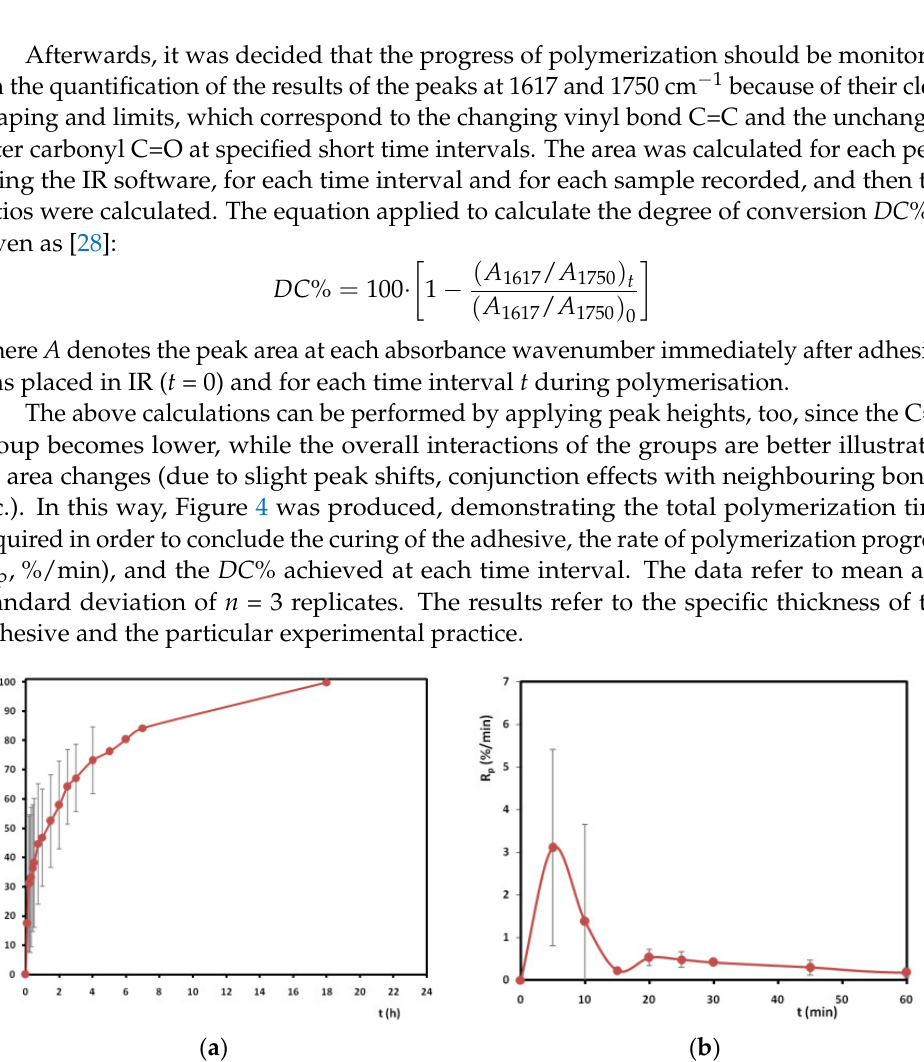
Figure 3. Peaks’ changes in FT-IR spectra at1950–1500 cm −1 ( a ) and 3300–2750 cm −1 ( b ) regions, indi- cating the polymerisation progress of the adhesive.